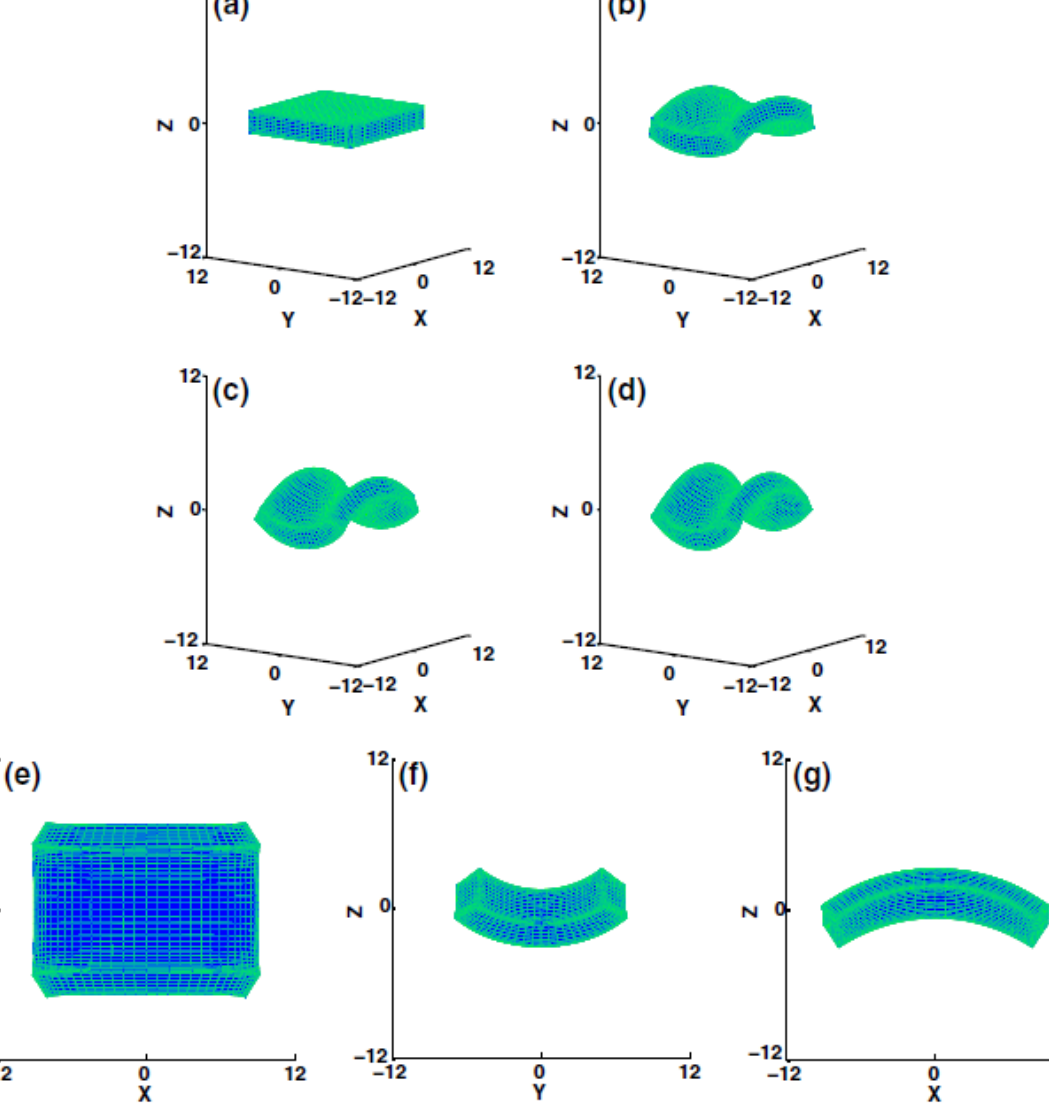
Figure 14. The shape evolution of the LCE when inhomogeneous temperature distribution is applied. ( a ) the LCE is in its initial state ( b , c ) both show two transitional states, and ( d ) demonstrates the sample after reaching steady state condition. ( e – g ) illustrate the LCE sample of ( d ) from three different points of view [112] (Reprinted with permission from [112]).